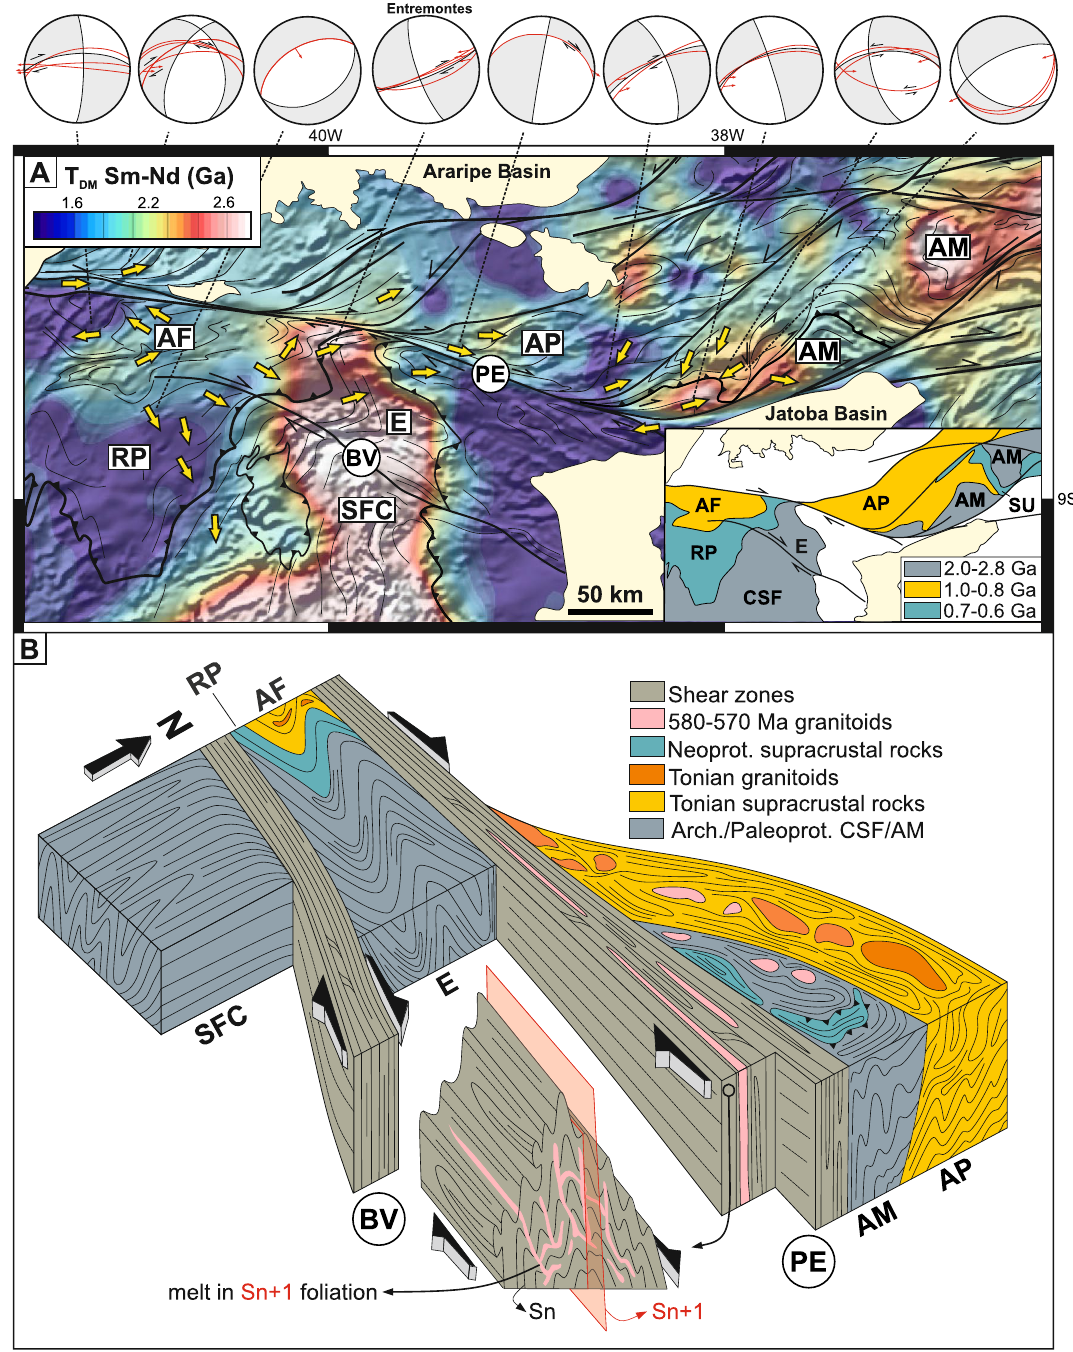
Figure 4. Transpression and correlation of terranes in the central and southern Borborema Province. ( A ) Sm–Nd T DM age map of the south Borborema Province and northern edge of the São Francisco Craton with magnetic first derivative image as background. Inset illustrates dextral displacements of the 1.0 to 0.8 Ga and the older 2.8–2.0 Ga terranes across the Pernambuco shear zone, resulting from transcurrent tectonics. The yellow arrows indicate the direction of tectonic transport. BV Boa Vista shear zone, PE Pernambuco shear zone, E Entremontes block, AF Afeição domain; RP Riacho do Pontal fold-and-thrust belt; AP Alto Pajeú terrane; AM Alto Moxotó terrane, SFC São Francisco Craton. The stereograms report the Sn + 1 foliation along with its stretching lineation (red arrows) and shear sense when available. The Sm–Nd T DM ages were gridded in the ArcGIS software using Inverse-Distance-Weighted Interpolation (IDW). ( B ) Block diagram illustrating the transpressive regime in the Entremontes block with progressive displacement and increased deformation from the craton to the Entremontes block and to the Alto Moxotó terrane across the Boa Vista ( BV ) and the Pernambuco ( PE ) shear zones. Note how the Tonian rocks follow the same increase in deformation from the Afeição ( AF ) domain to the Alto Pajeú ( AP ) terrane. Together, they indicate a dextral displacement across the Pernambuco shear zone of ≈ 200